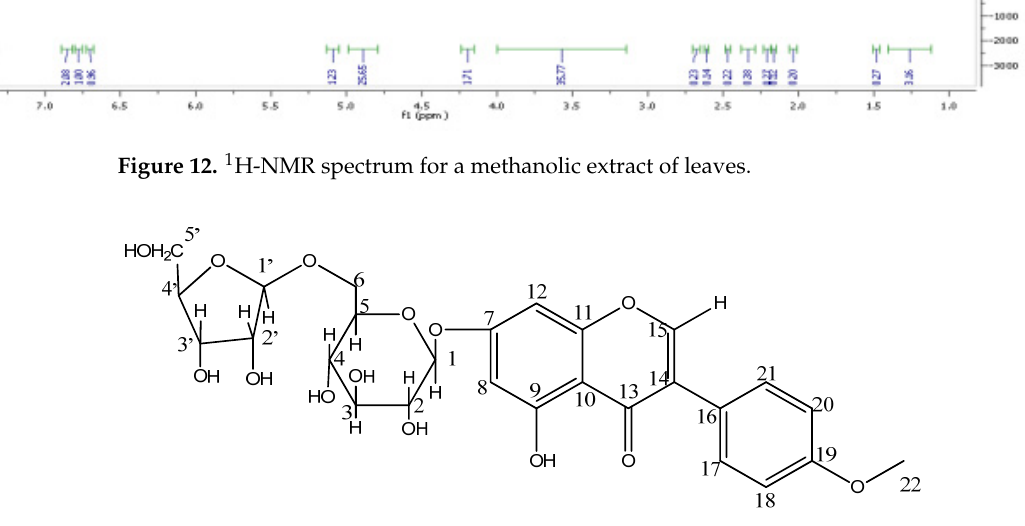
Figure 13. Hypothetical structure for isoflavonoid glucosides isolated from leaves of gorse.